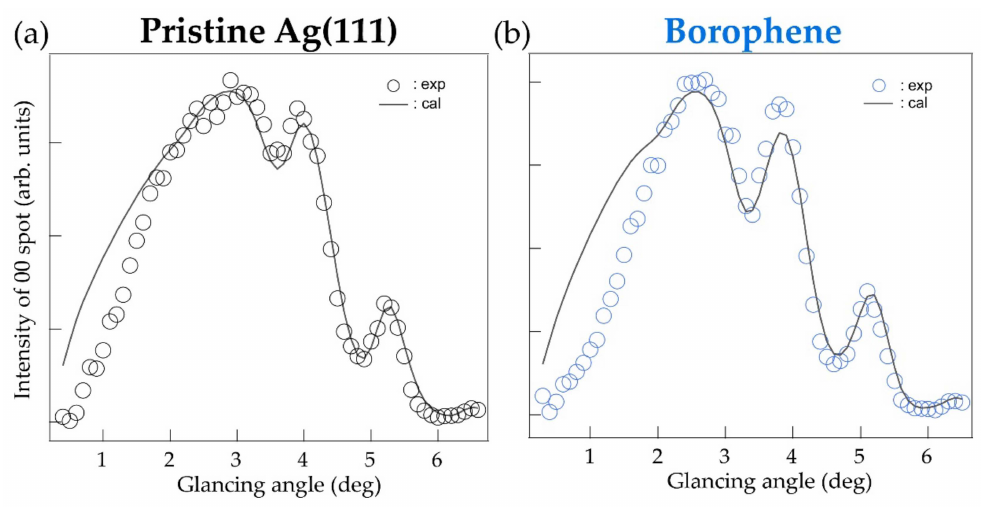
Figure 3. Rocking curves under one-beam (OB) condition with calculated curves for ( a ) pristine Ag(111) and ( b ) χ 3 -borophene on